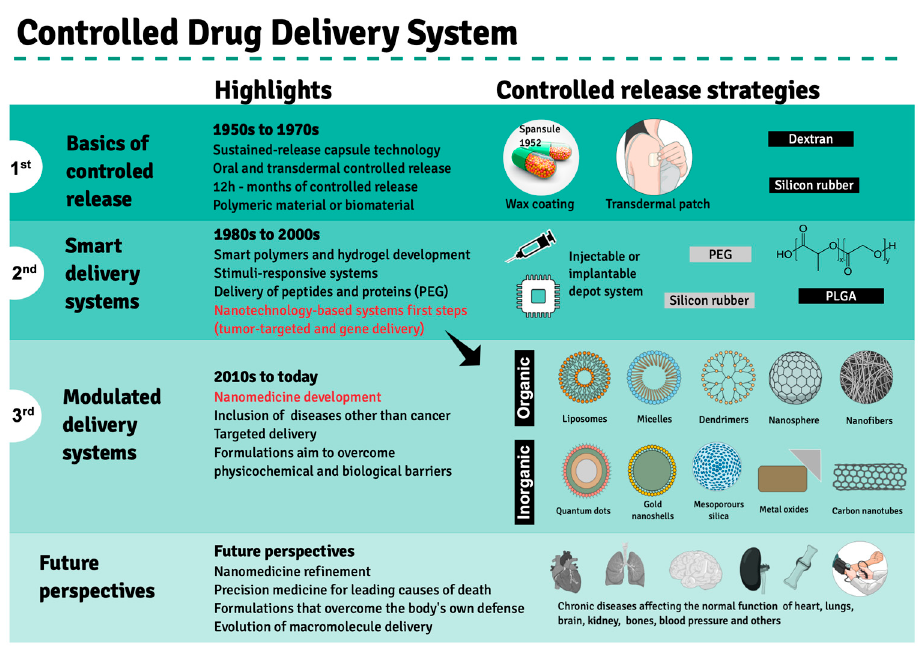
Figure 2. Development of controlled drug delivery systems. Three distinct development phases—1st, 2nd and 3rd generations—are highlighted based on therapeutic products approved by the FDA since the 1950s, when Spansule ® , the first drug release system, was approved for clinical use. The main highlights of each phase are depicted in the central column, while the main synthetic or biological material used in the drug delivery system preparation is indicated in the left column. The advent of nanotechnological drug delivery strategies is highlighted in red during the last decade of the second development phase. Future perspectives are exhibited at the bottom panel. Created using Mind the Graph (https://mindthegraph.com accessed on 14 August 2022). Table 1. Pre-clinical studies on nano-delivery systems demonstrated in cell cultures and animal models for the loading of therapeutics aiming at the treatment of several health disorders.